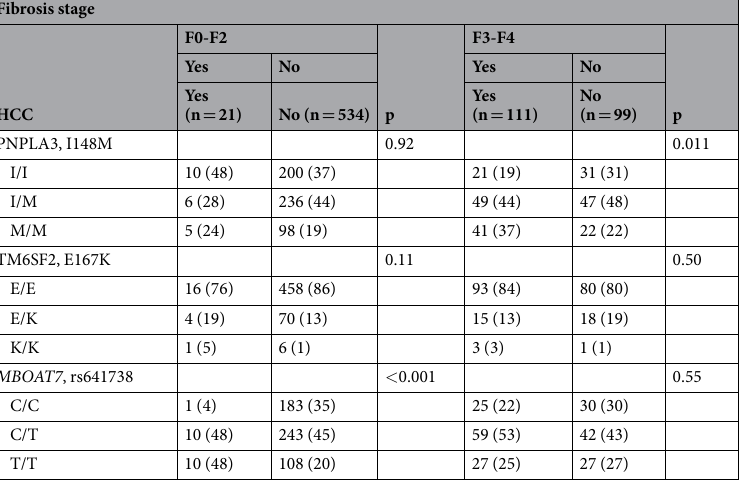
Table 2. Frequency distribution of PNPLA3 , TM6SF2 , and MBOAT7 variants according to hepatocellular carcinoma (HCC) in 765 Italian NAFLD patients stratified by the severity of fibrosis (stage F0-F2 vs. F3-F4). (): % values. HCC. Hepatocellular carcinoma. Comparisons were performed by logistic regression setting HCC as dependent variable, and the association of genetic variants was analyzed assuming additive models.